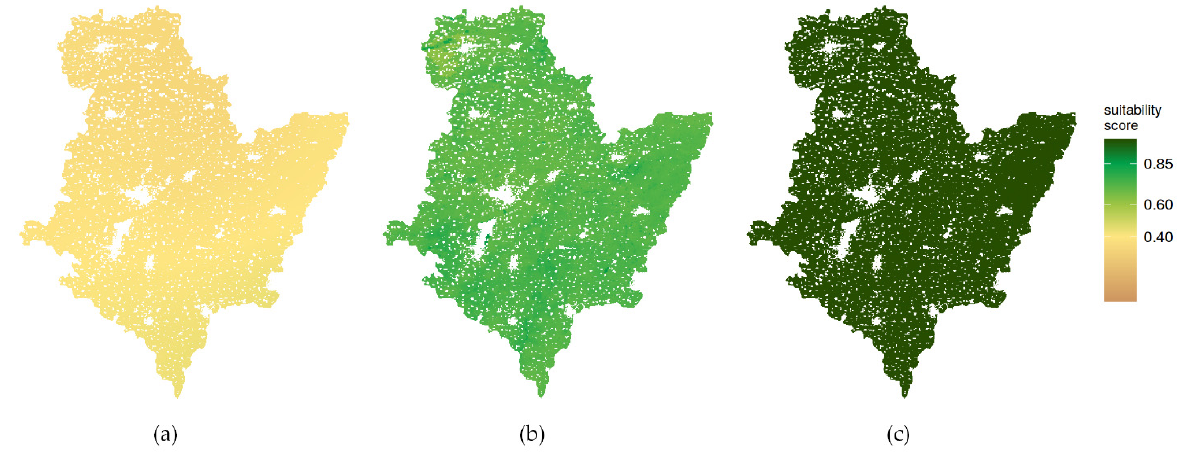
Figure 11. Suitability score maps for maize in Hengshui: ( a ) climatic factors; ( b ) soil factors; ( c ) topographic factors.